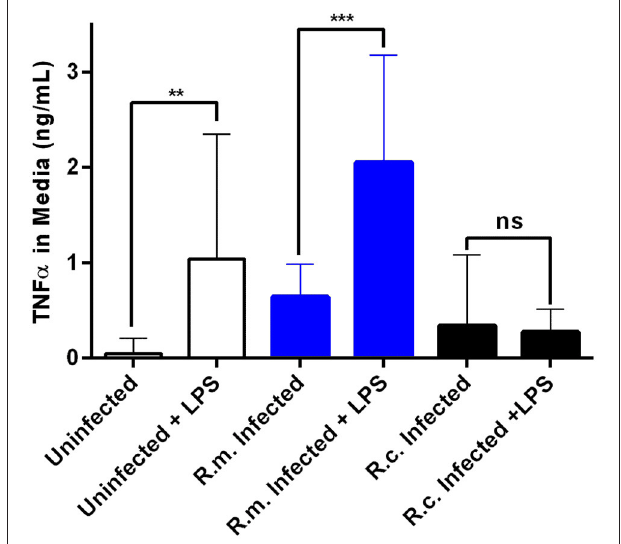
FIGURE 4 | Rickettsia conorii switches macrophage immune responses into a hyporesponsive state. Quantification of TNF α concentration in the culture media of uninfected (white), R. conorii - (black) and R. montanensis -infected (blue) THP-1 macrophages upon stimulation with E. coli O26:B6 LPS.